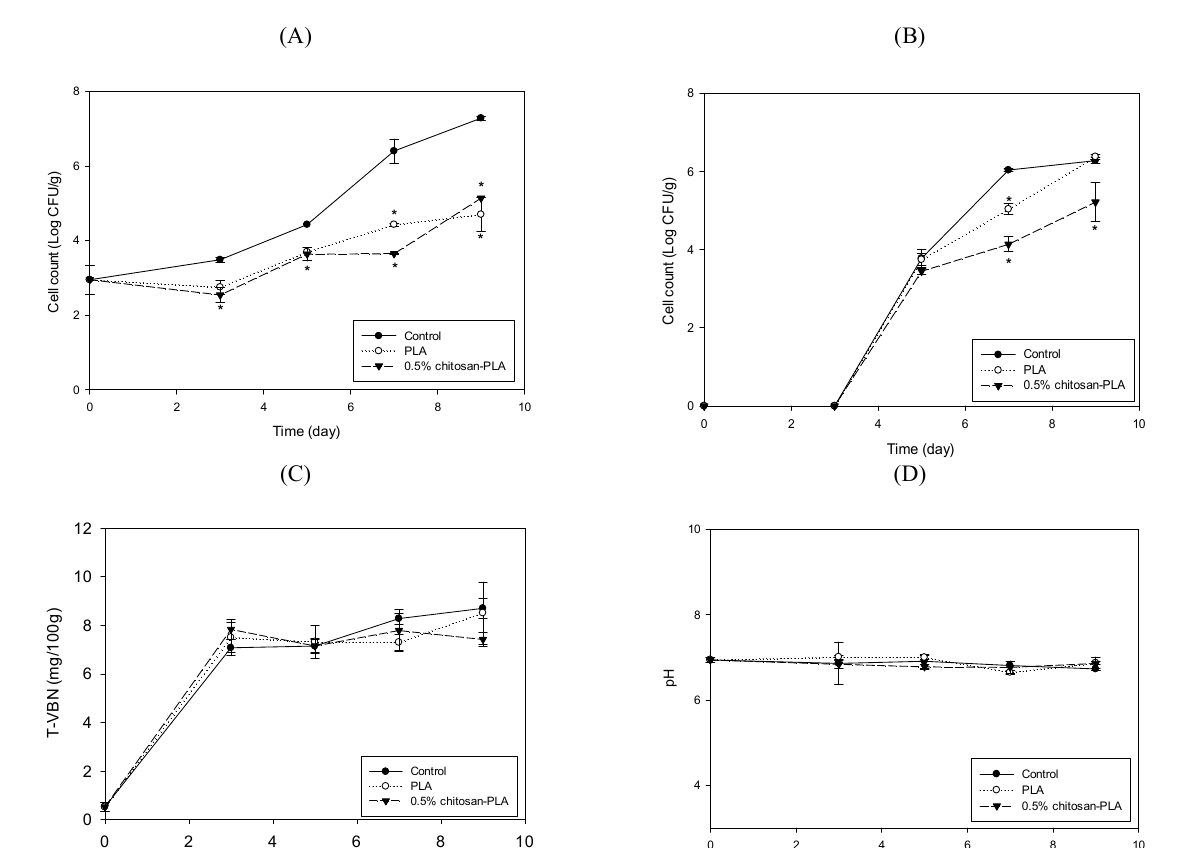
Figure 5. Changes in mesophilic count ( A ); psychrotrophic count ( B ); total volatile basic nitrogen content ( C ); and pH value ( D ) of fish fillet ( Epinephelus fuscoguttatus x Epinephelus lanceolatus ) uncovered (control) or covered with PLA or 0.5% CH–PLA films during storage at 4 °C. Data are presented as mean ± SD ( n = 3). * significantly different compared to control ( p < 0.05)